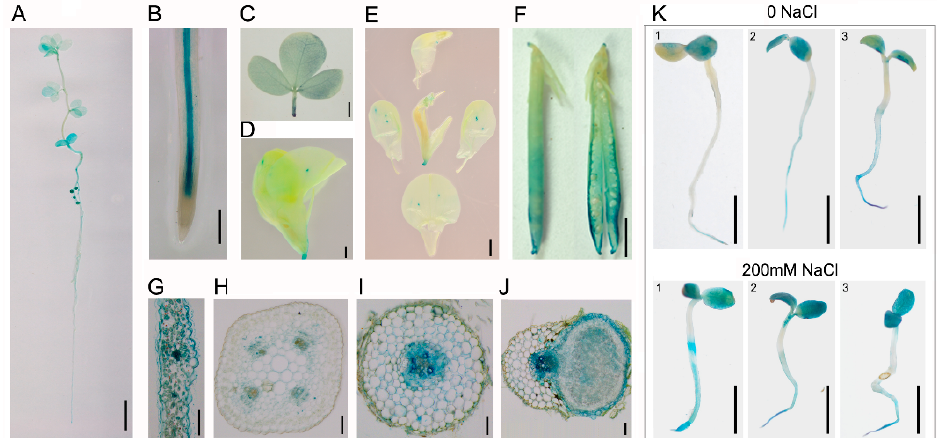
Figure 1. GUS staining of pLjPLT3: GUS plant. ( A ) GUS staining of a 4-week-old pLjPLT3: GUS seedling. ( B ) The root of a pLjPLT3: GUS plant showing GUS activity in the central cylinder. ( C ) Leaf showing GUS activity in the vascular bundle. ( D , E ) Flower of a pLjPLT3: GUS plant showing GUS activity in petiole and stamens. ( F ) Pod of a pLjPLT3: GUS plant. ( G , H , I ) Cross section of leaf, stem, and root showing the expression of LjPLT3 mainly in vascular bundles and parenchyma cells. ( J ) Cross section of nodule showing GUS activity in the cortical cell, vascular bundles, and infection zone. ( K ) GUS activity in pLjPLT3: GUS seedlings under NaCl treatment. 1, 2, 3 means different pLjPLT3: GUS lines. Scale bar = 1 cm ( A , K ), 0.5 cm ( B , C ), 0.2 cm ( D , E , F ), 250 μ m ( G , I , J ), 100 μ m ( H ).